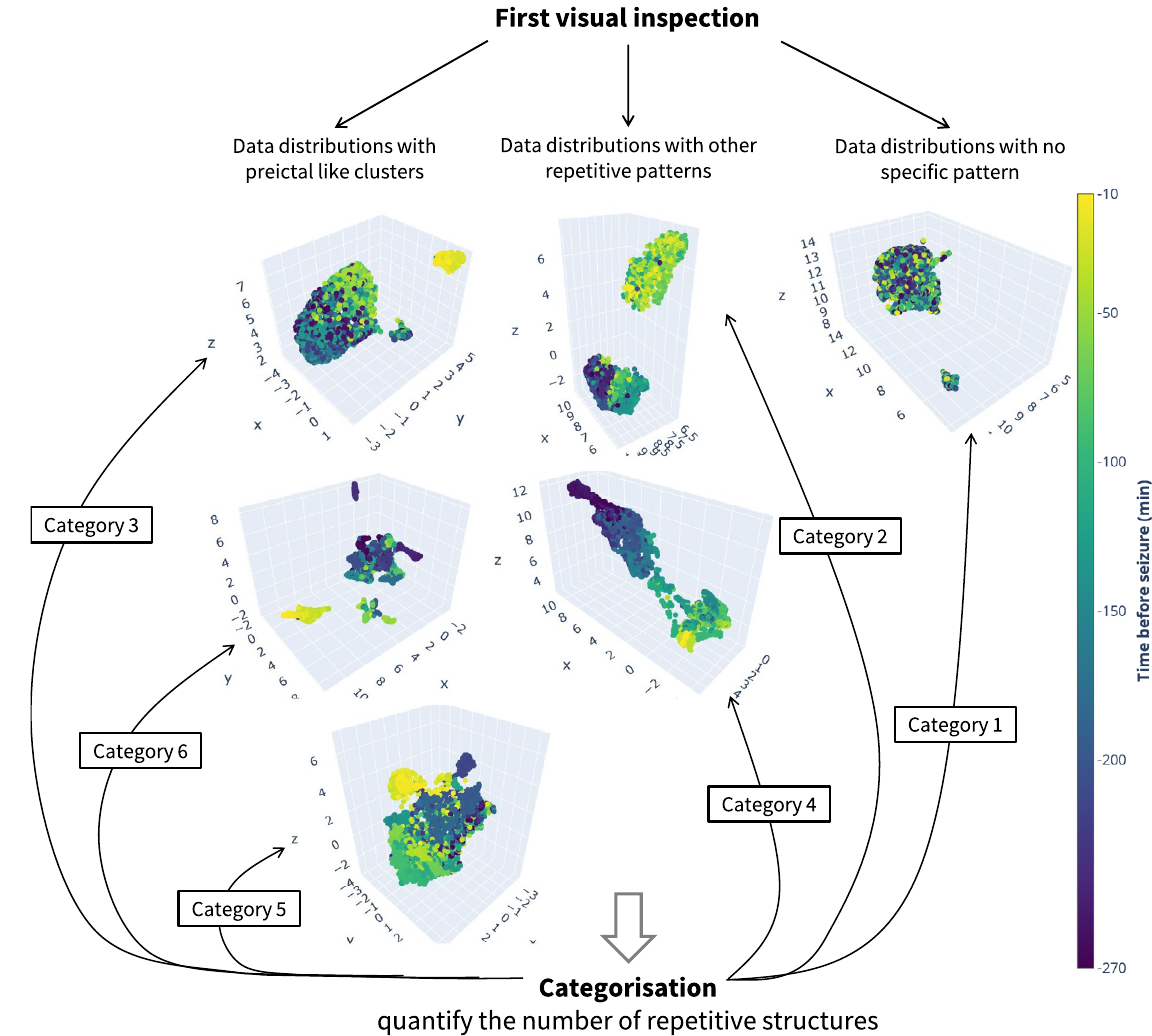
Figure 3. Process of searching for the preictal interval. Each example of the six data distribution categories is represented by the projected UMAP components (labelled x, y, and z). The seizure occurs at 0 min. Category 1 was obtained from patient 21902, seizure 4, reduced multivariate features. Category 2 was obtained from patient 98102, seizure 5, reduced univariate nonlinear features. Category 3 was obtained from patient 58602, seizure 4, reduced multivariate features. Category 4 was obtained from patient 110602, seizure 3, reduced univariate linear features. Category 5 was obtained from patient 98202, seizure 2, reduced univariate nonlinear features. Category 6 was obtained from patient 123902, seizure 2, reduced univariate linear